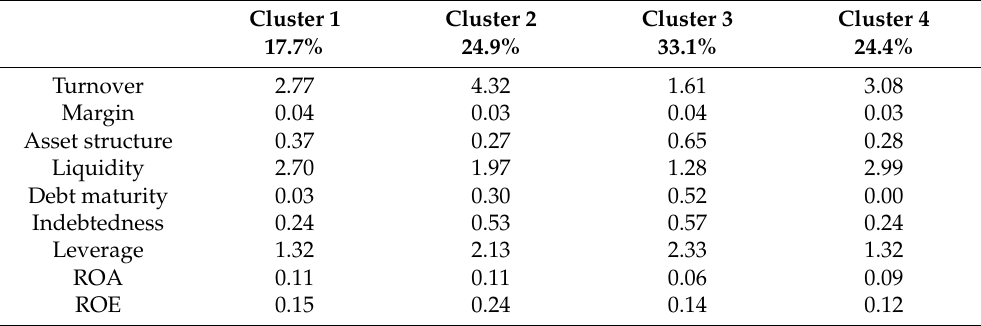
Table 5. Cluster centers: standard financial ratios computed from cluster geometric means. Un- weighted analysis.